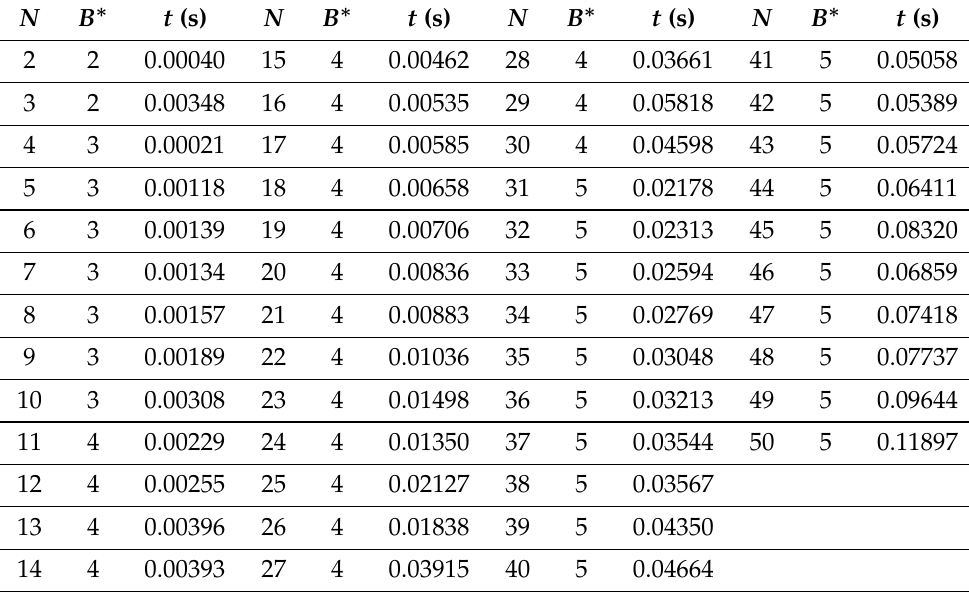
Table 2. Optimal bandwidth B ∗ for 49 instances of N = C .